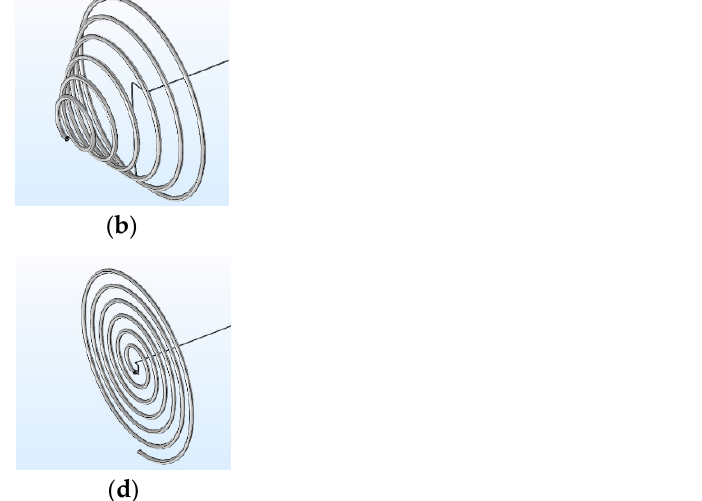
( b ) Figure 7. Influences of structure lengths on transmission efficiency under asymmetry: ( a ) length of transmitting structure; ( b ) length of receiving structure. From part a of Figure 7, it can be clearly seen that increasing the length of the trans- mitting structure has little impact on the system’s transmission efficiency. From part b of Figure 7, the transmission efficiency tends to improve as the length of the receiving struc- ture increases. Especially, the efficiency improves rapidly when the length of the receiving structure is shorter than 10 m. In summary, the transmission efficiency is mainly influenced by the length of the receiving structure. Therefore, in the design of a one-way single-wire power transfer sys- tem structure, a shorter transmitting structure and a longer receiving structure are recom- mended. 3.2. Volume Optimization As mentioned above, increasing the length of the receiving structure can effectively